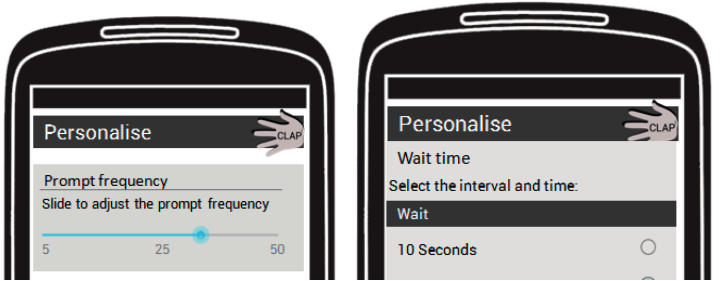
Figure 5. Screen shots of proposed personalization features allowing the user to set the frequency of the prompt and how long the system allows them to respond to a